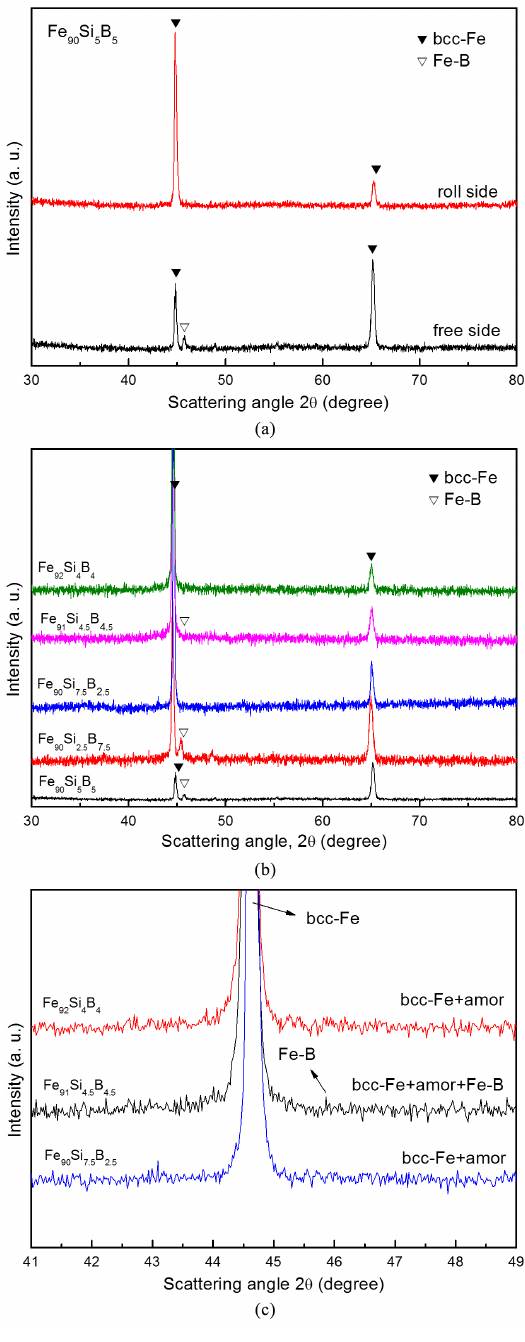
Figure 1. (a) XRD patterns (Cu-Kα, λ=1.5406) of Fe ribbon measured on roll side and free side, respectively. (b) XRD patterns (Cu-Kα, λ=1.5406) of Fe Fe Si Si and Fe Si B alloy ribbon. (c) Details of XRD patterns 91 4.5 4.5 92 4 4 from 41 to 49 degree of scattering angle